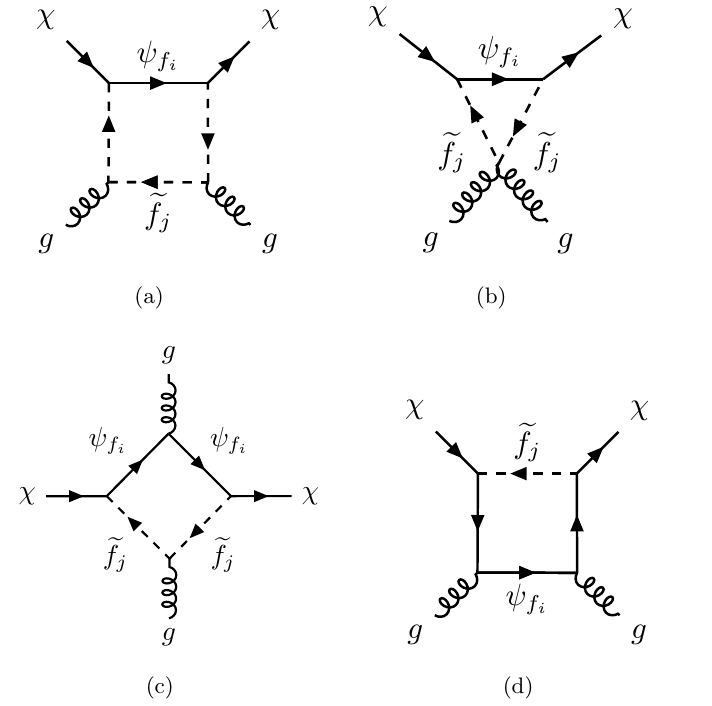
Figure 4 . Feynman diagrams for e(cid:11)ective DM-gluon